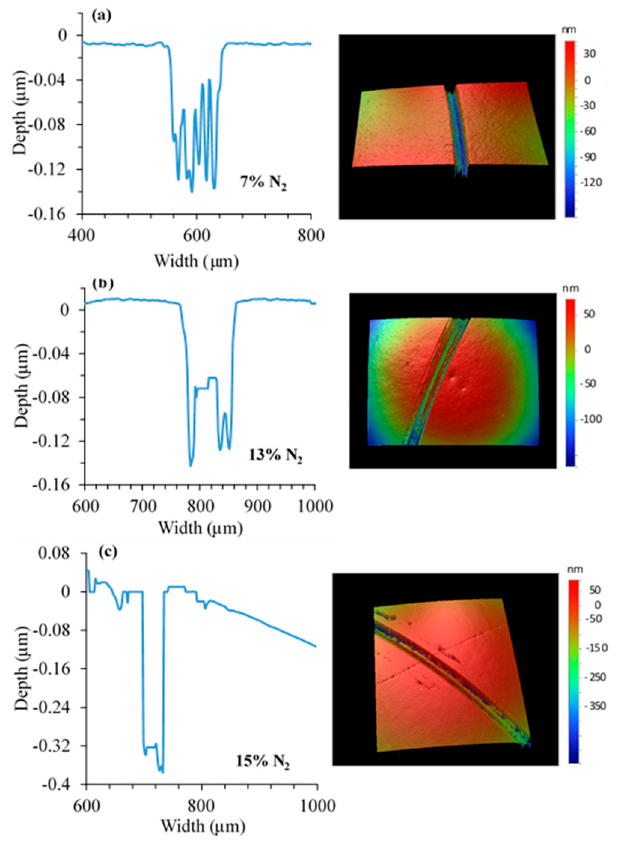
Figure 11. Wear track profile for films sputtered with ( a ) 7%, ( b ) 13%, and ( c ) 15% N 2 content.